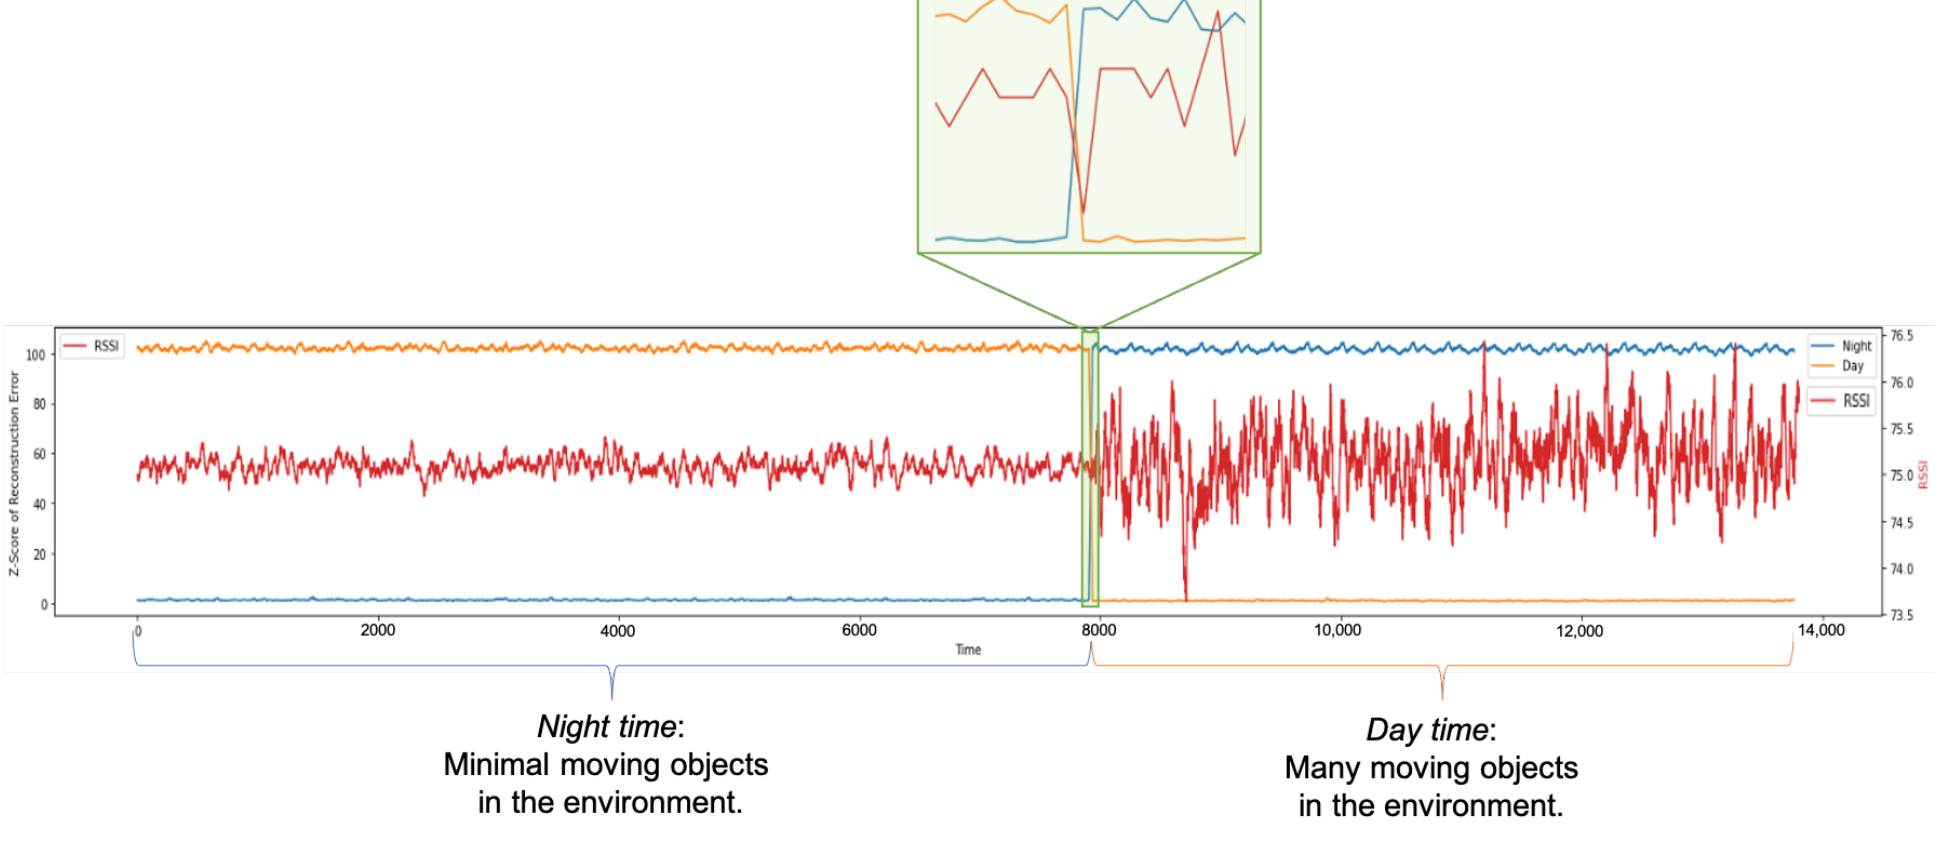
Figure 13. Tracking reconstruction error of two trained models during an entire day. The crossover point between the two reconstruction error lines (orange and blue) coincide with increase in volatility of RSSI stream (the red line)—a clear indicator to be used to switch between trained